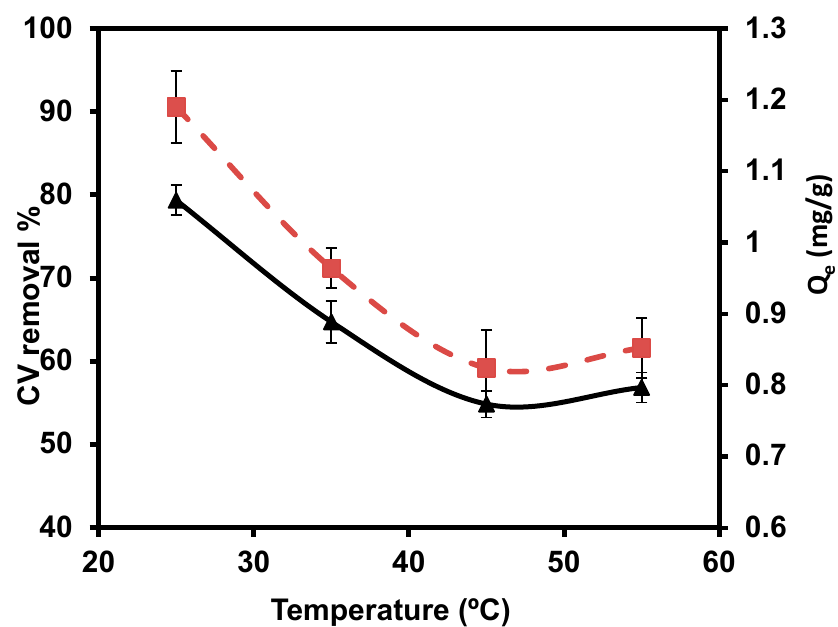
Figure 9. Impact of several temperatures on the removal percentage of CVD.